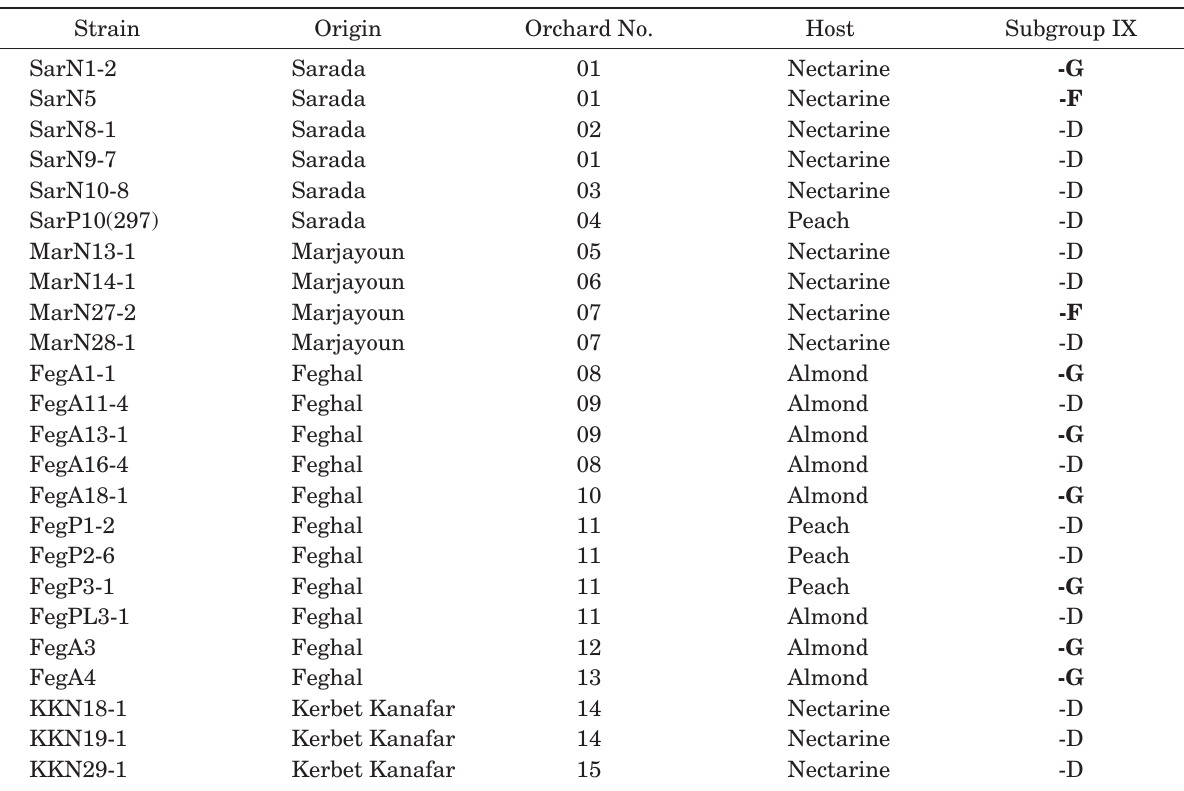
Table 1. Occurrence of ‘ Ca. P. phoenicium’ strains, belonging to distinct 16SrIX subgroups, in orchards of Lebanon regions. New subgroups con fi rmed by actual RFLP analyses are indicated in bold. Strain Origin Orchard